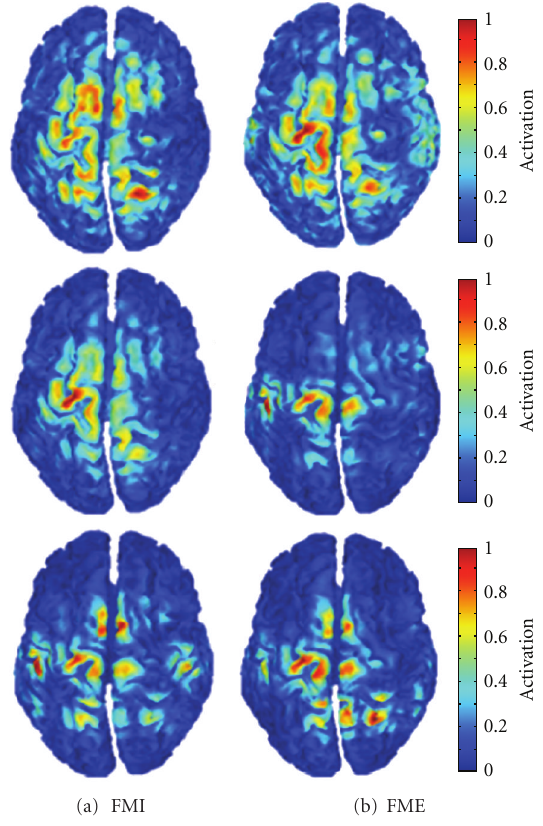
(a) FMI Figure 4: Cortical source activation maps for one representative subject during (a) Foot Motor Imagery (FMI) and (b) Foot Motor Execution (FME). The activation of supplementary motor areas (SMAs) varies in di ff erent poststimulus instances (rows) and can be observed to be more intense during